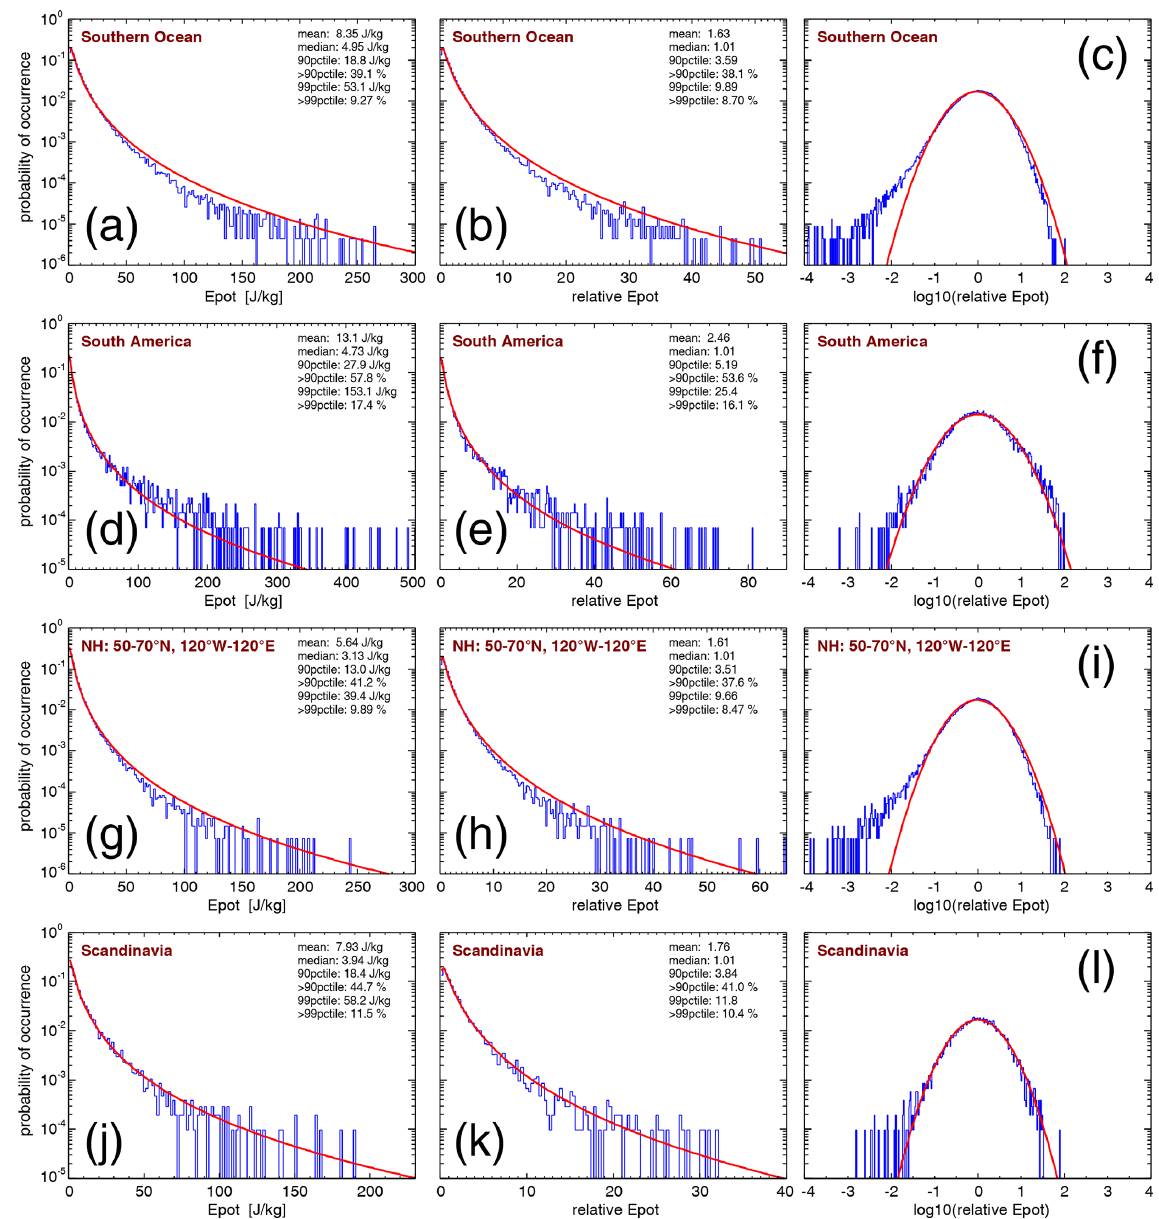
Figure 10. Same as Fig. 8 but for gravity wave potential energies ( E pot ).